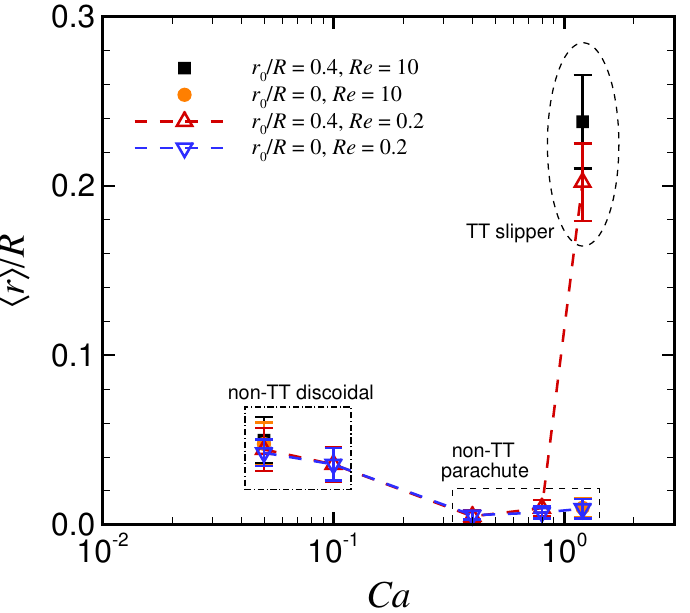
/ R as a function of Ca for initial r (cid:104) (cid:105) denotes time average. The (cid:104)·(cid:105)